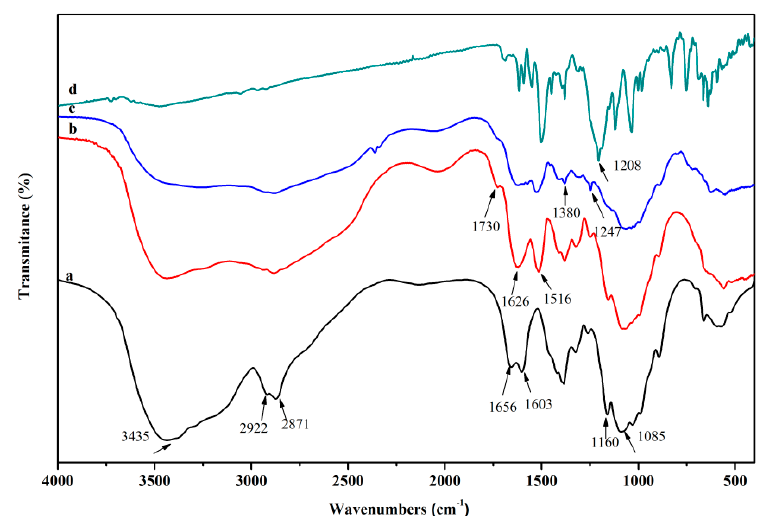
Figure 2. FTIR spectra of a, chitosan; b, O -CMCS; c, chitosan-based biopolymer dye; and d, Acid Red GR.